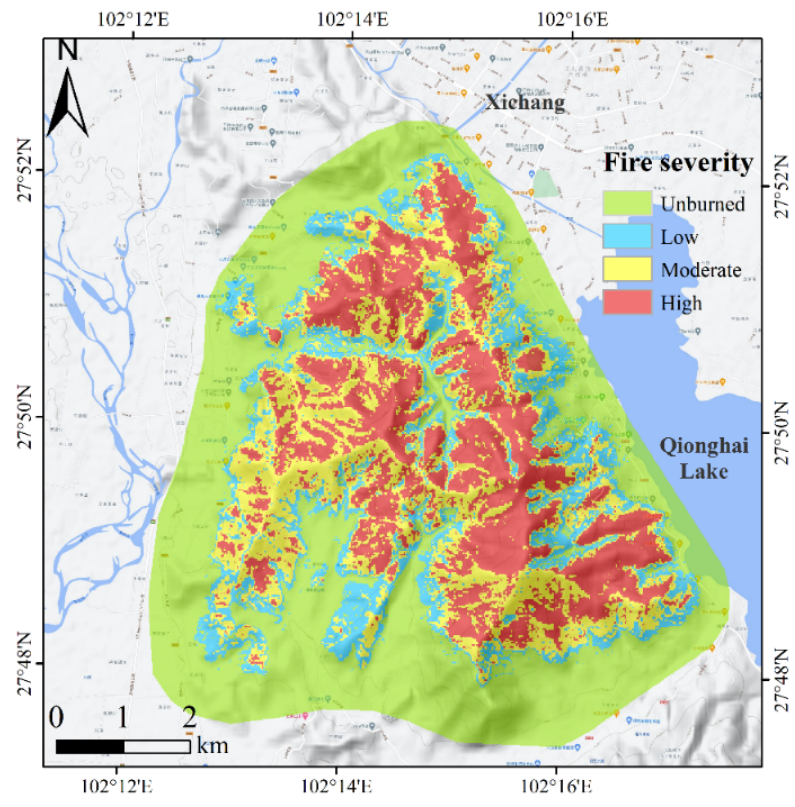
Figure 6. Characteristics and spatial distribution of fire severity in the study area.